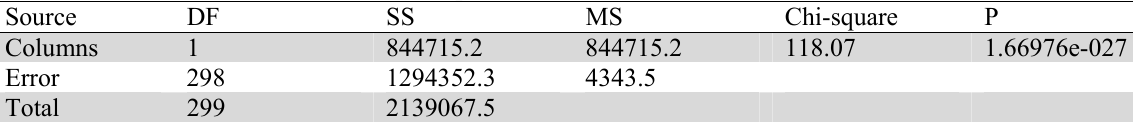
Results of Kruskal-Wallis Test for Comparison between PSO & IWO Source DF SS MS Columns